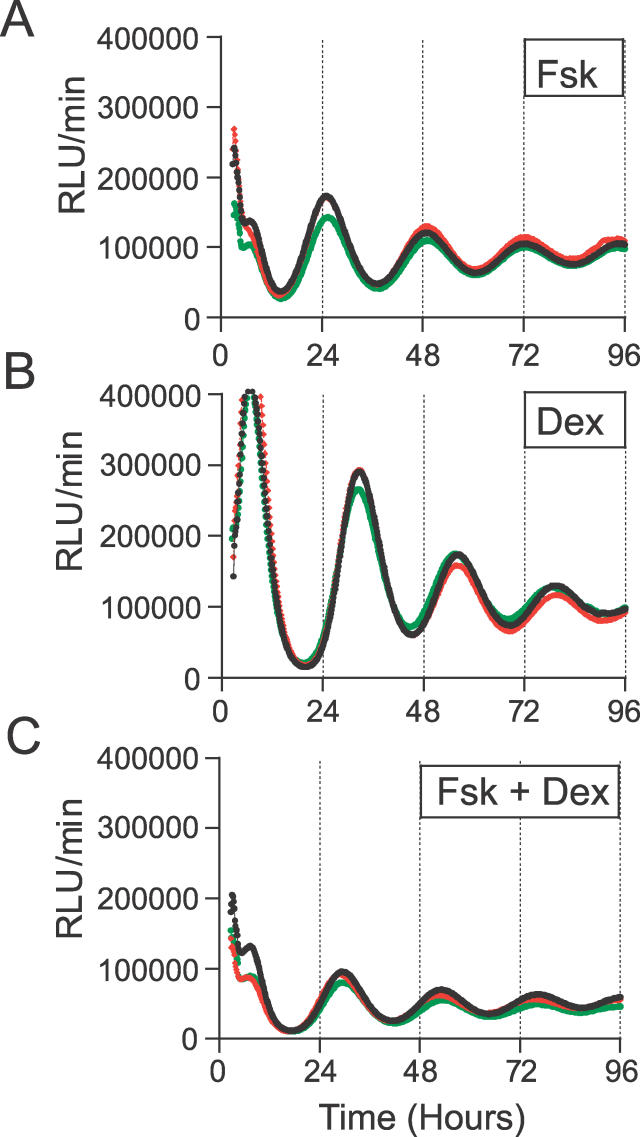
Comparison of Phases Initiated by a Combination of Fsk and Dex StimuliRat-1/Pmper2::dLuc cells were treated with 10 μM Fsk or 100 nM Dex or 10 μM Fsk + 100 nM Dex for 2 h. The phases of rhythms initated by each treatment were: Fsk = −2.92 ± 0.79 (n = 5), Dex = −9.95 ± 0.26 (n = 6), and Fsk + Dex = −7.60 ± 1.26 (n = 5). Time 0 is the onset of stimulation. Three replicate measurements are shown for each treatment. (A) 10 μM Fsk. (B) 100 nM Dex. (C) 10 μM Fsk + 100 nM Dex.